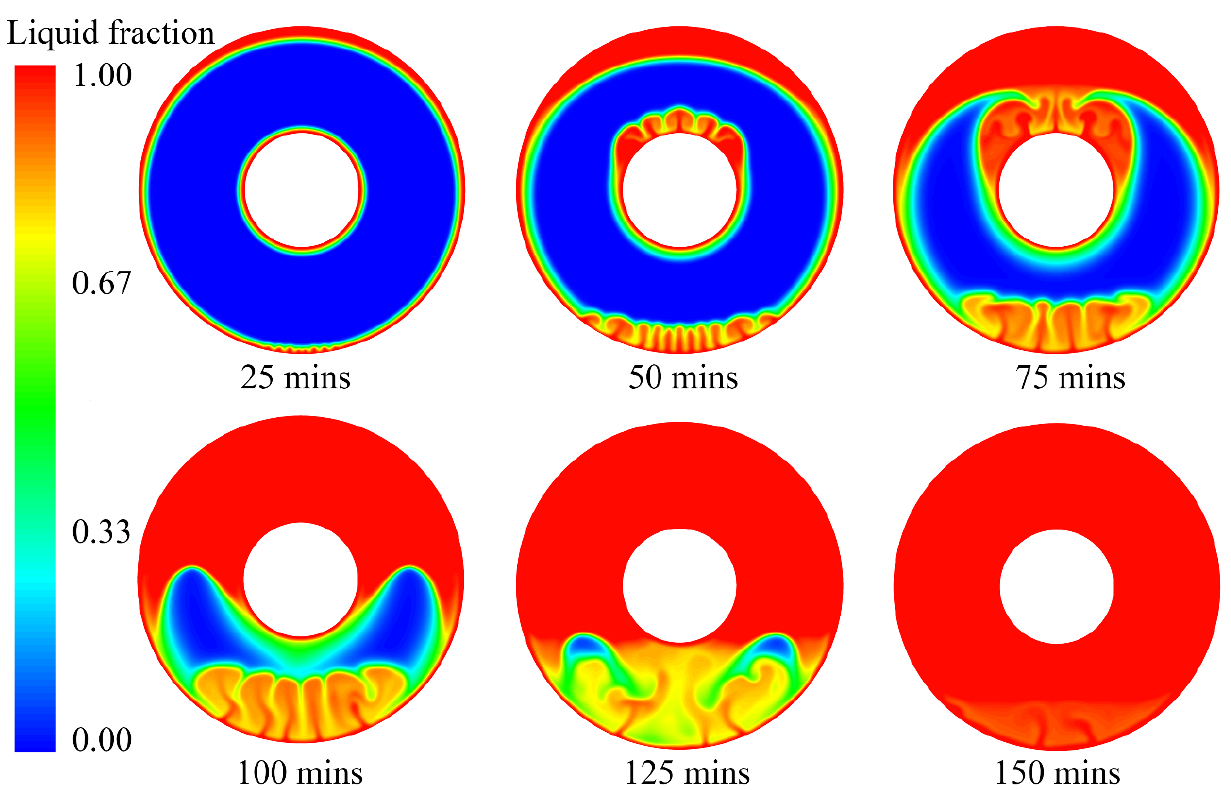
Figure 7. Liquid fraction of PCM during the melting process.